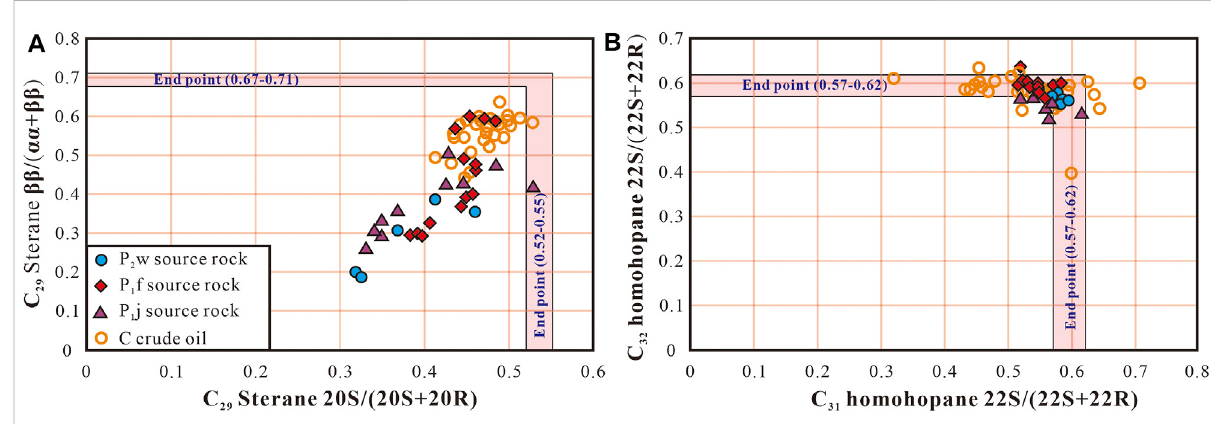
FIGURE 8 Comparison of the thermal maturity of the studied source rocks and crude oils. (A) Plot of C 29 sterane 20S/(20R + 20S) versus C 29 sterane ββ / ( αα + ββ ); (B) Plot of C 31 homohopane 22S/(22S + 22R) versus C 32 homohopane 22S/(22S + 22R).